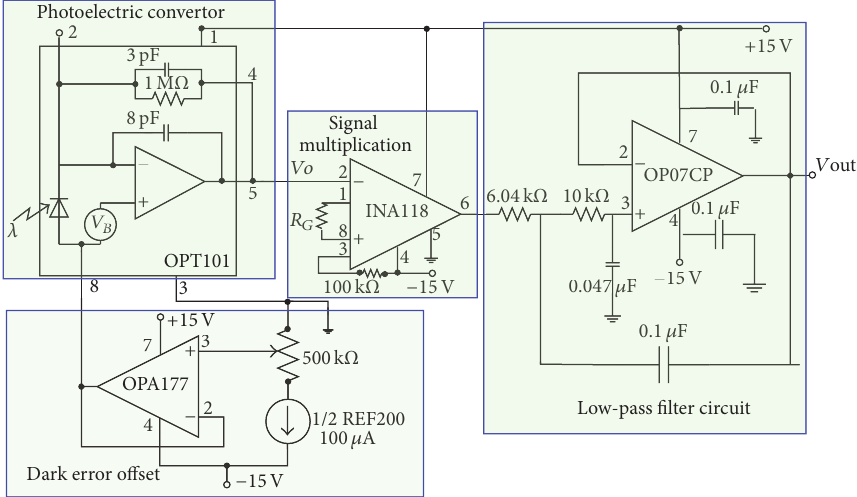
Figure 5: Light intensity to voltage converter and Low-pass filter circuit.